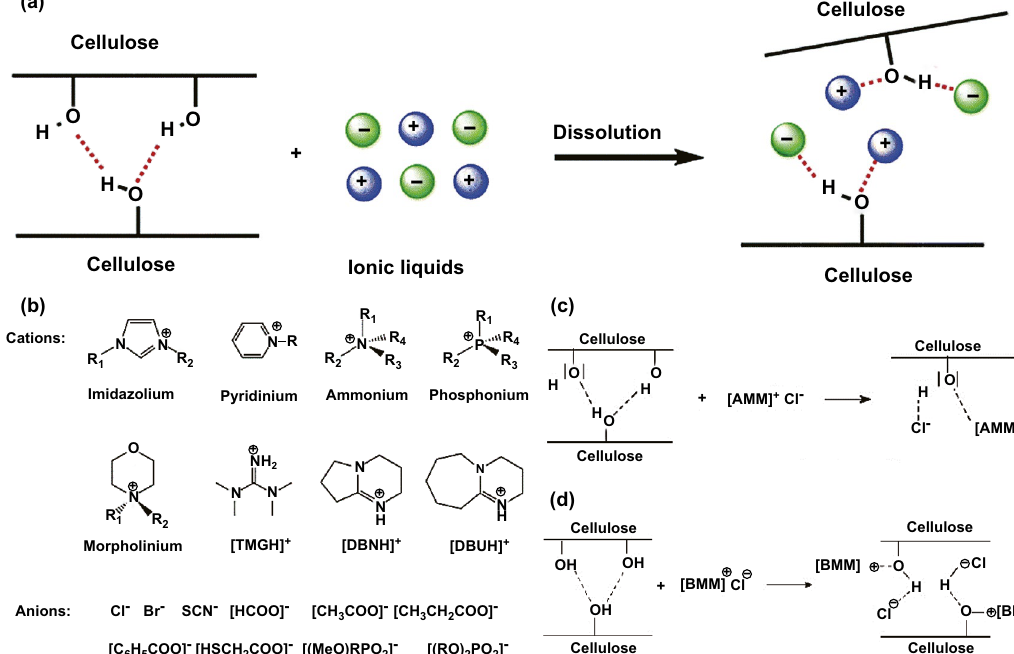
Fig. 8 a Typical cations/anions based–ILs structures for dissolving NCs. b NCs dissolution mechanism in ILs. Reproduced with permission from Ref. [22] Copyright © 2017, American Chemical Society. c NCs dissolution mechanism in AmimCl. Reproduced with permission